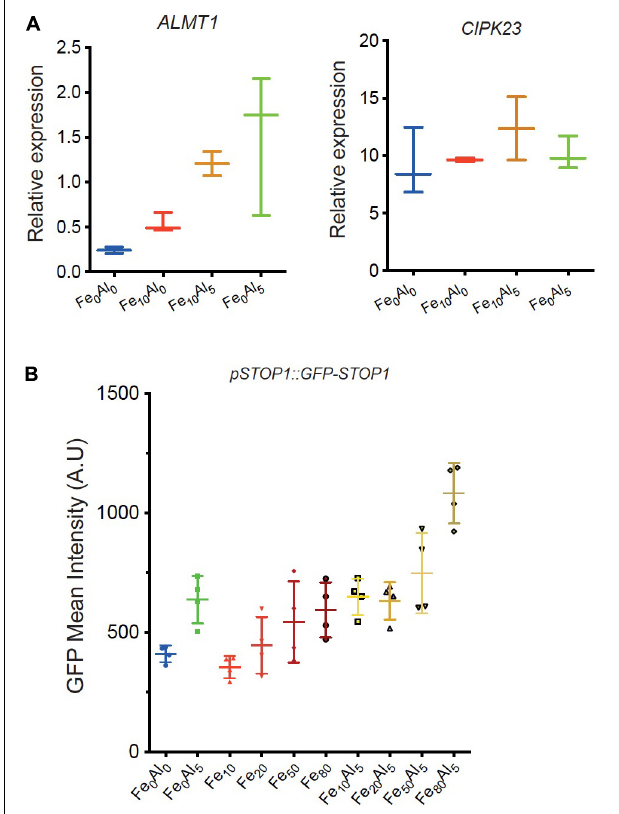
FIGURE 5 | Relative expression of STOP1 downstream genes ALMT1 and CIPK23. (A) Relative quantification (RT-PCR) of ALMT1 and CIPK23 STOP1 downstream genes at the indicated condition at pH 5.7 (see section “Material and Methods”), n = 3 experiments, one of the three independent experiments is shown. (B) Measurement of GFP fluorescence (A.U.) (see section “Materials and Methods”) of 5 days old pSTOP1:GFP-STOP1 seedlings were grown on P 500 Fe 10 pH 5.7 medium and transferred 4 h on the indicated medium pH 5.7 ( n = 4). The multiple comparisons, Kruskal-Wallis non-parametric test was performed with the application of the Dunn’s correction. One of the three independent experiments is